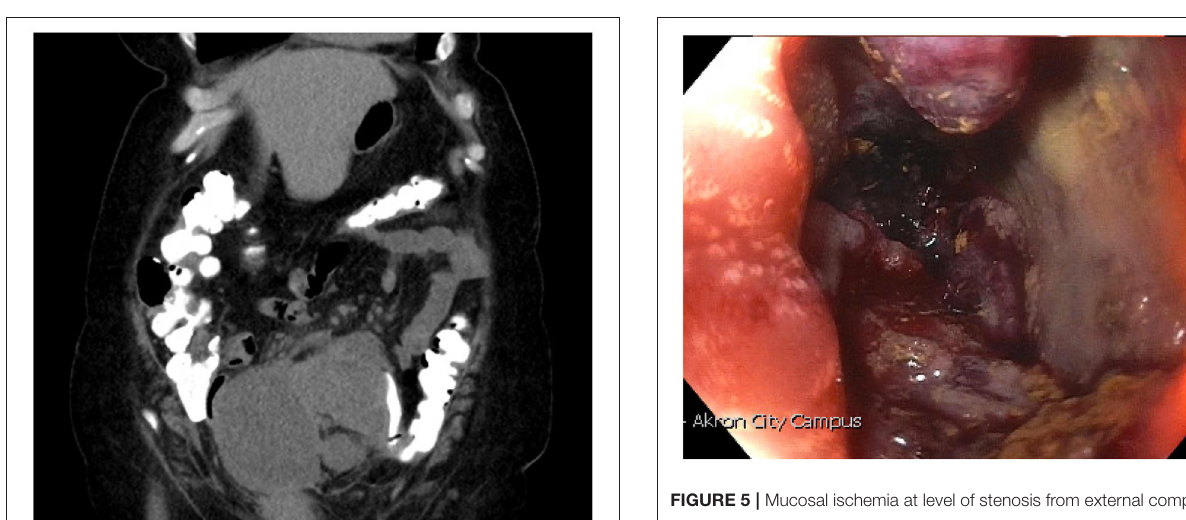
Prior studies examining gene expression profiles in surgical samples of various primary human tumors have identified a potential link between triple negative breast cancer and